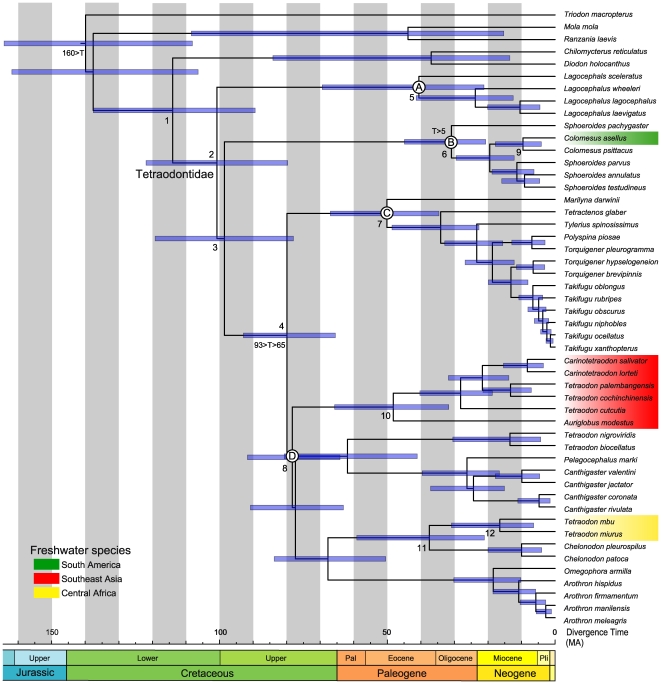
Divergence times among tetraodontid pufferfishes from the relaxed-molecular clock method with the dataset 12nRTn.Node numbers 1–12 and three time constraints are indicated above and below nodes, respectively. Horizontal bars indicate 95% credible intervals of the divergence time estimates.